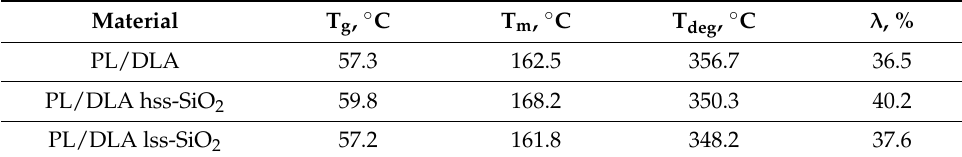
Table 3. Thermal properties of the nanocomposite foils and the pure polymer.